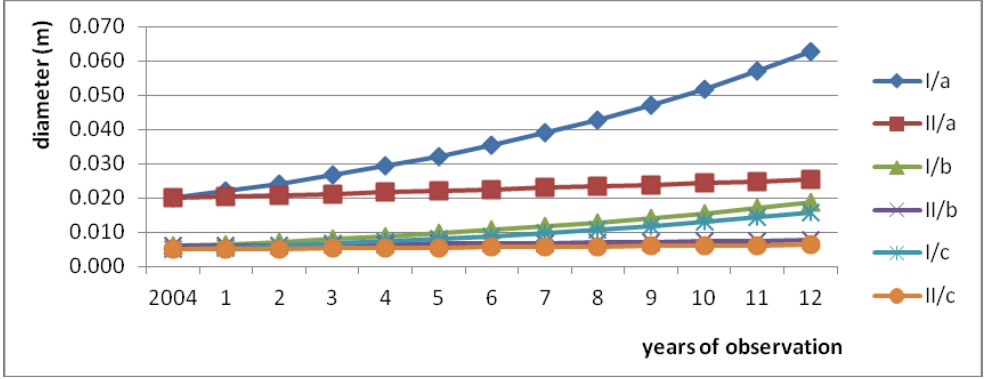
Figure 6. Variability in the diameter of branches occurring during years of simulation.